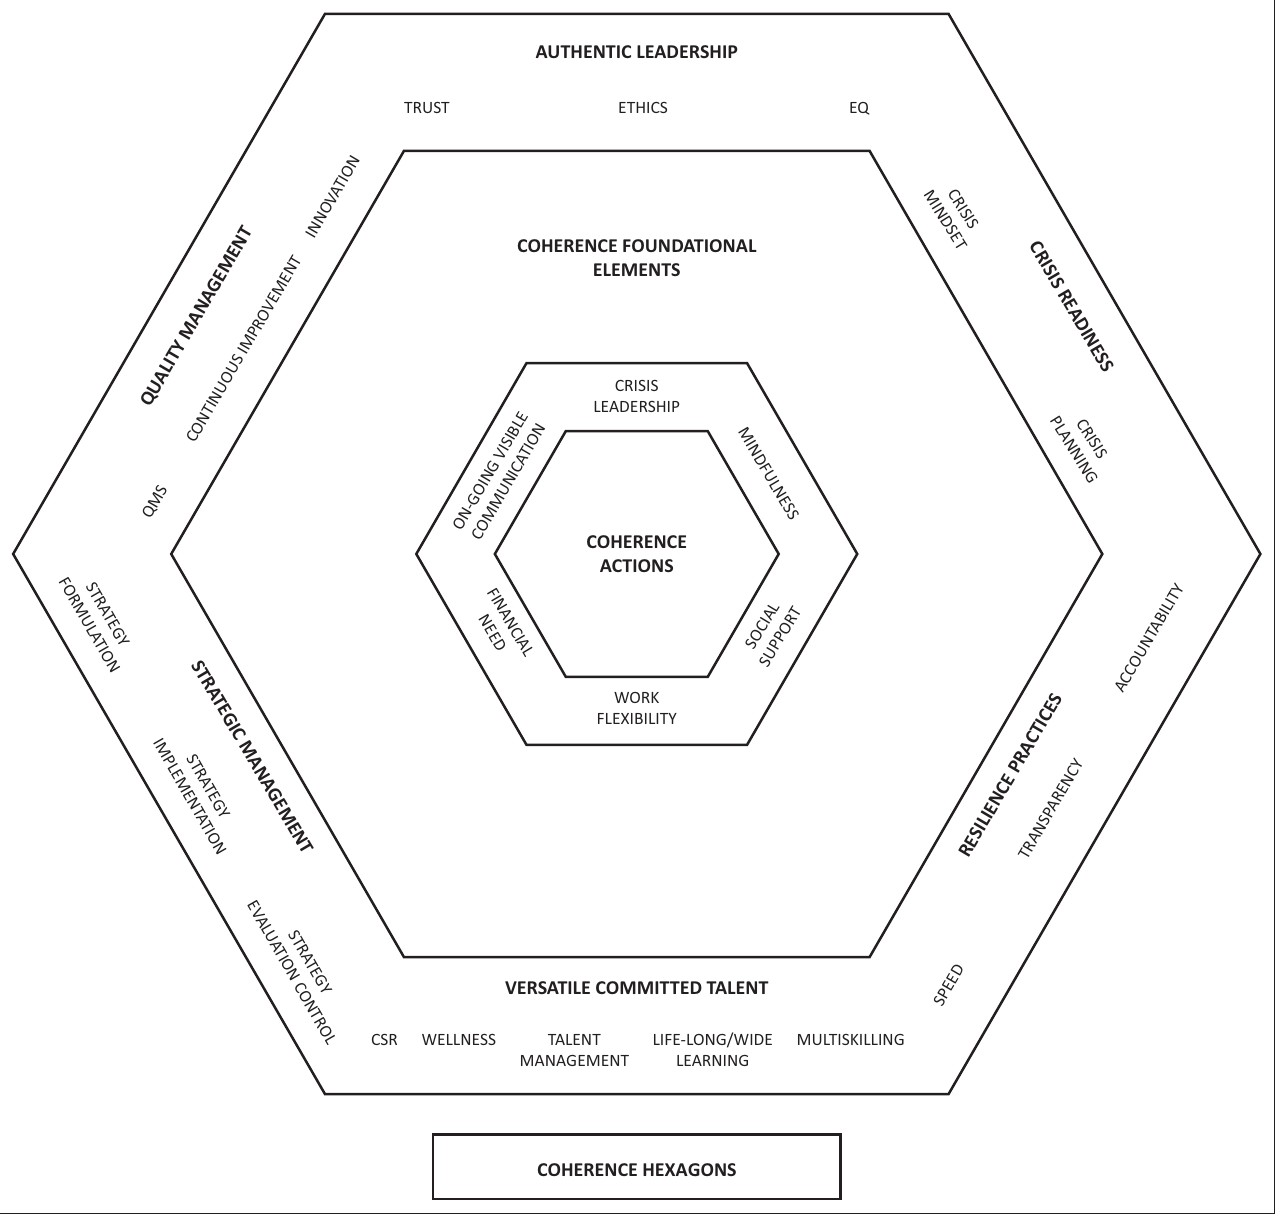
FIGURE 1: The Coherence Hexagons